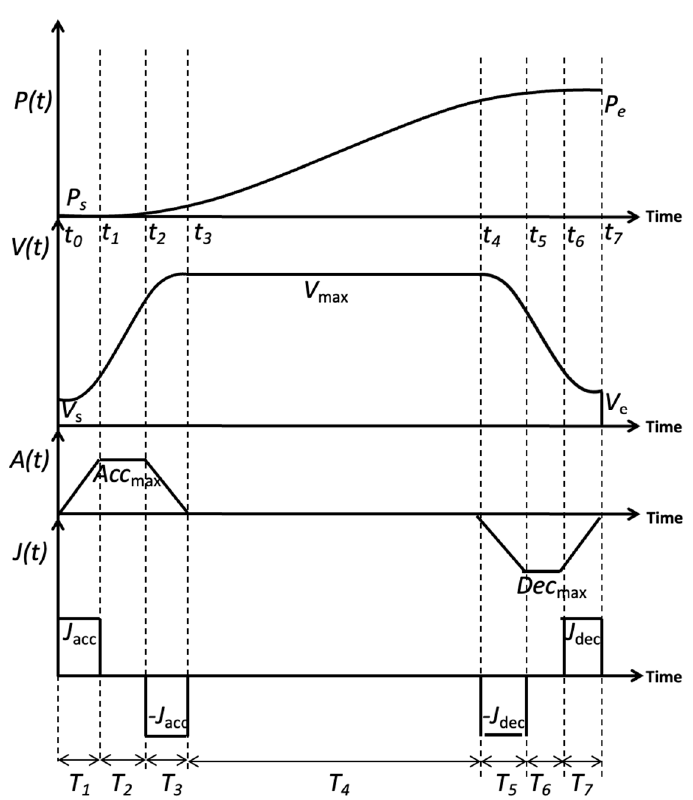
Figure 1. S-curve velocity profile for jerk-limited trajectory generation.